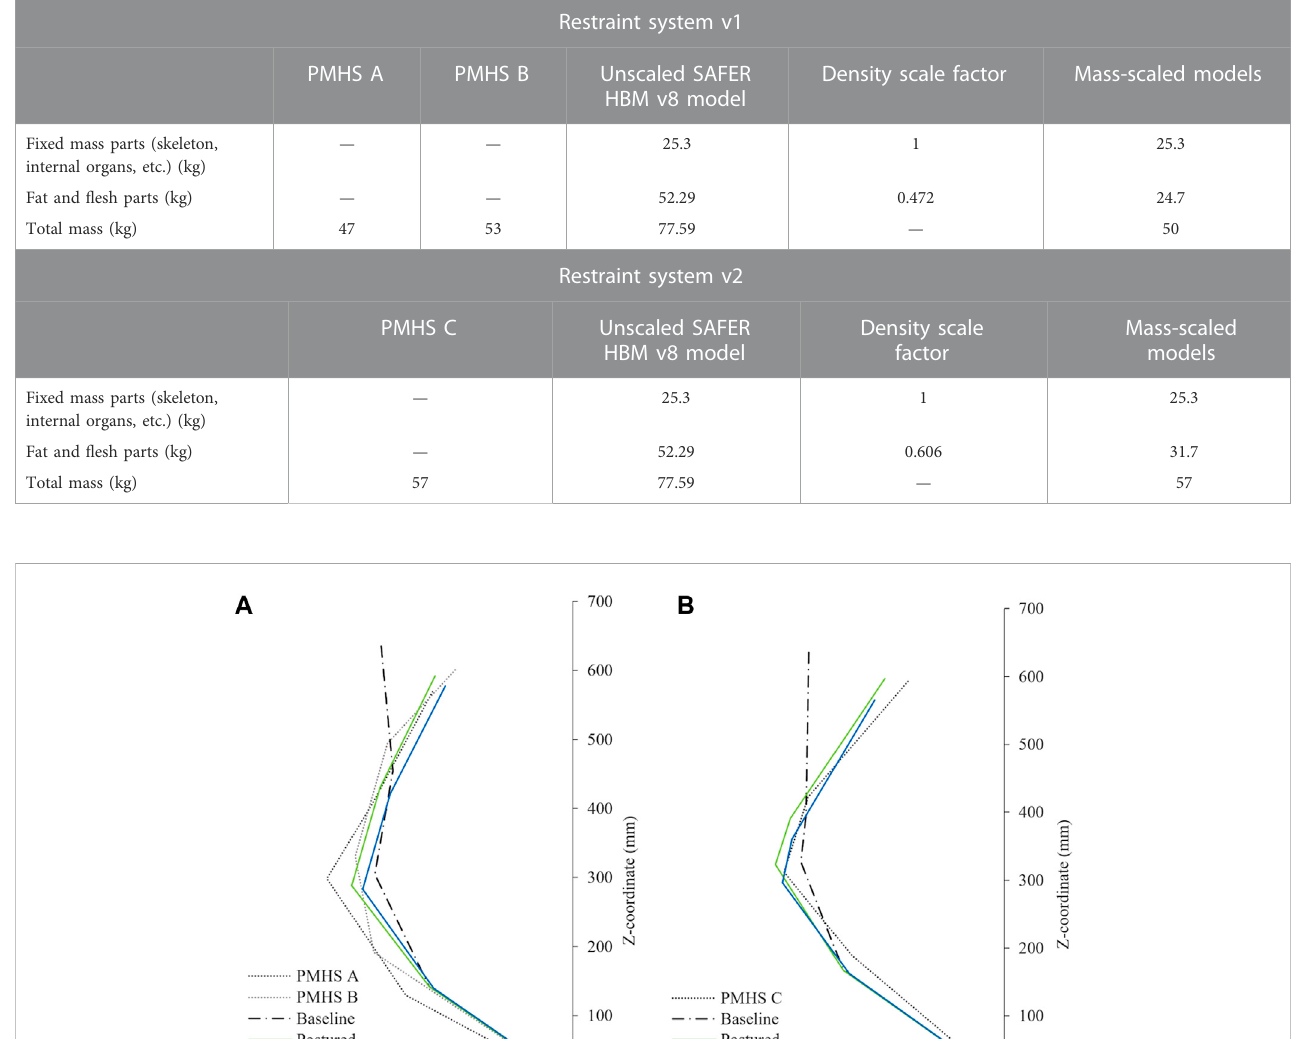
TABLE 2 Mass modi fi cation of the mass-scaled models ’ fl esh and fat parts.